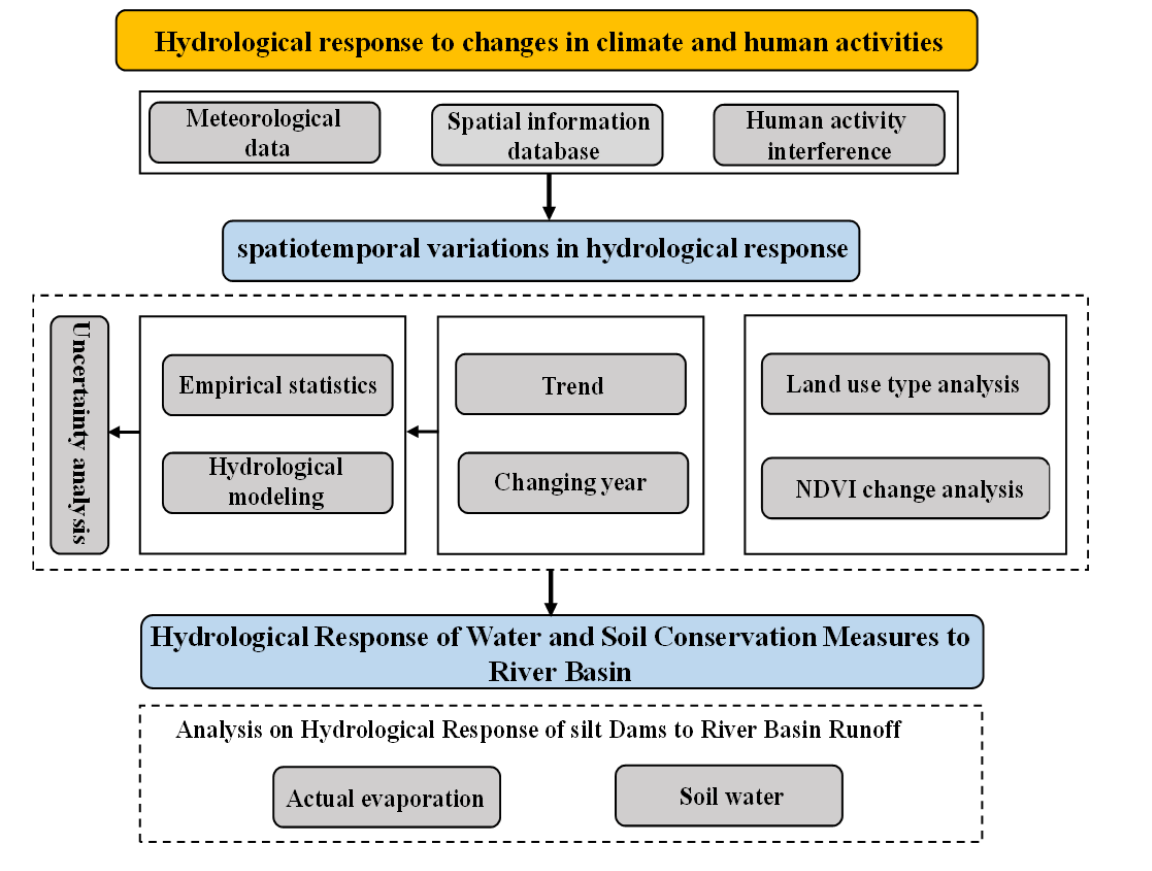
Figure 4. Research methods and technology flow chart used in this study.